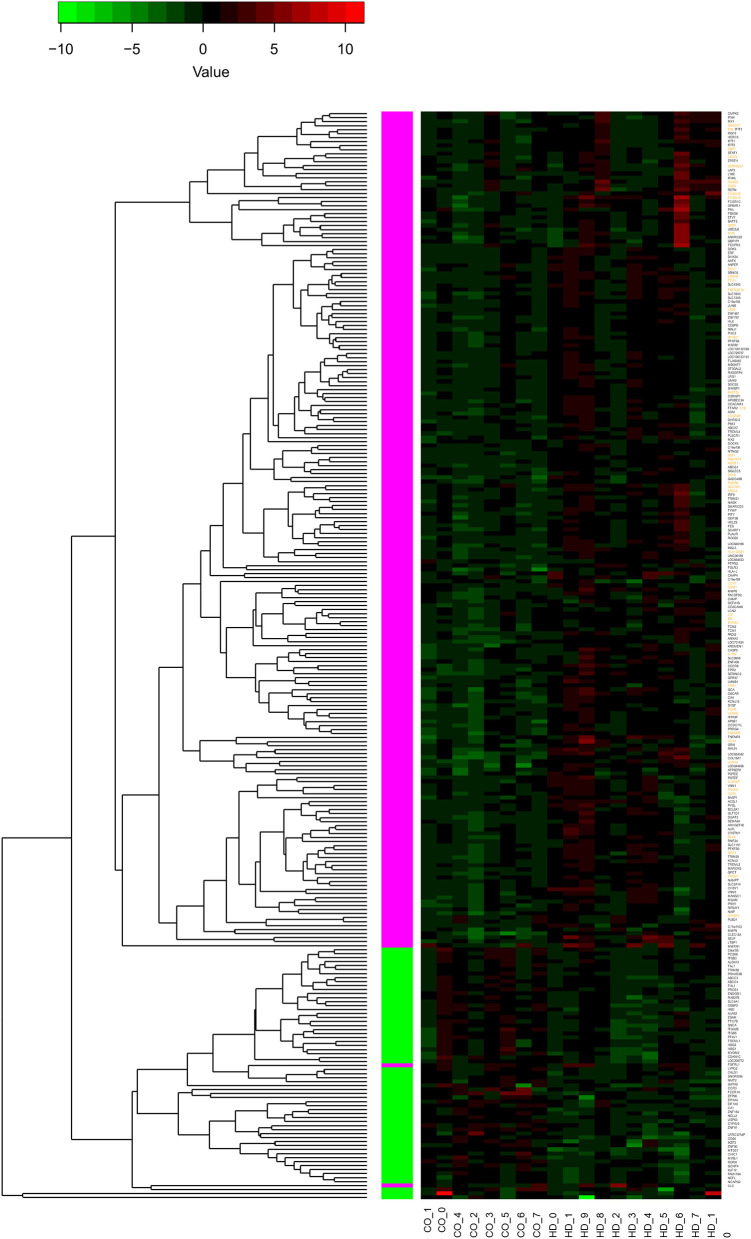
Differential expression of 274 genes. The heatmap represents the expression values of 274 genes with significant differential expression in peripheral blood of individuals with HD compared to controls (q-value < 0.05). The values are z-scores based on the log2 (FPKM) values, with 0 FPKM values set to 0.01, and modified to account for outliers following (16). Labels at the bottom indicate sample type: controls to the left (CO_), HD to the right (HD_). The dendrogram indicates results of hierarchically clustering the genes according to their expression values. Genes upregulated or downregulated in HD with respect to controls are indicated with magenta and green boxes, respectively. Gene labels in orange indicate genes with functions related to inflammation or immune response (see text for details); all of these genes are upregulated.